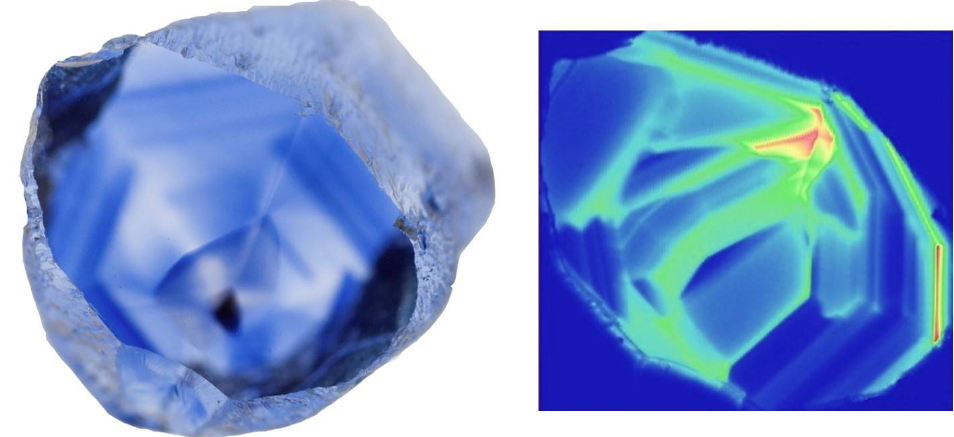
Minerals 2021 , 11 , x FOR PEER REVIEW Figure 15. Photo of a Madagascar blue sapphire wafer showing hexagonal blue color zoning with sharp boundaries between blue and colorless zones ( left ). On the ( right ) is the Cr distribution map of the same sapphire created by PL mapping.